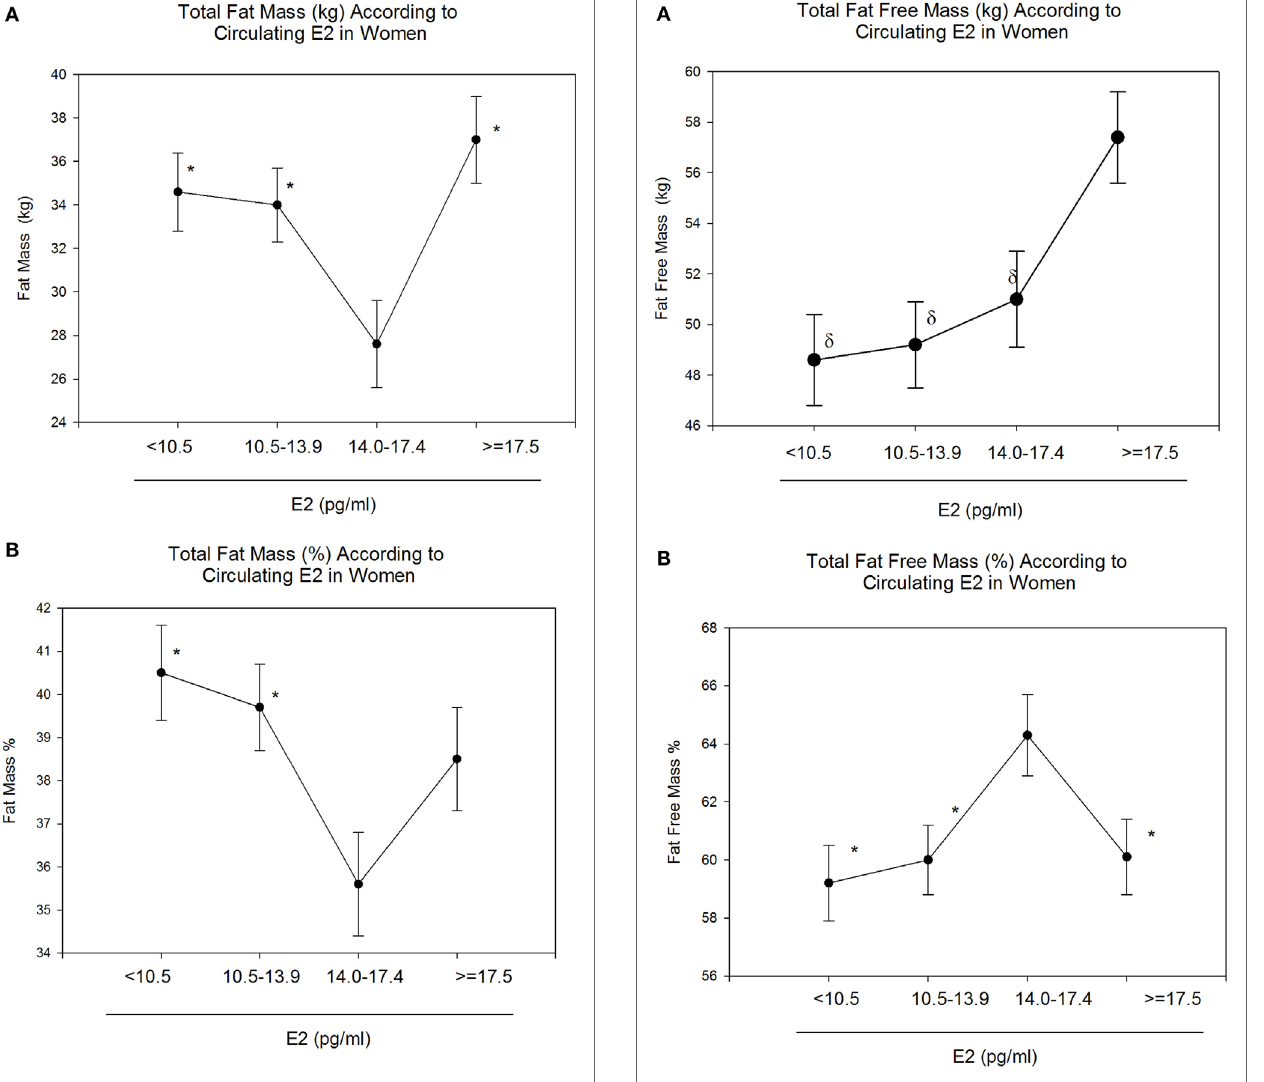
FigUre 2 | Total fat-free mass (FFM) (kg and %) according to estradiol (E2) categories. E2 levels between 14.0 and 17.4 pg/ml correspond to the highest FFM (%) (B) . However, absolute FFM increases with increasing E2 (a) . Data are reported as mean ± SE. *Comparison with group 3 (E2: 14.0–17.4), p < 0.05; δ Comparison with group 4 (E2: 10.5–13.9), p < 0.05.